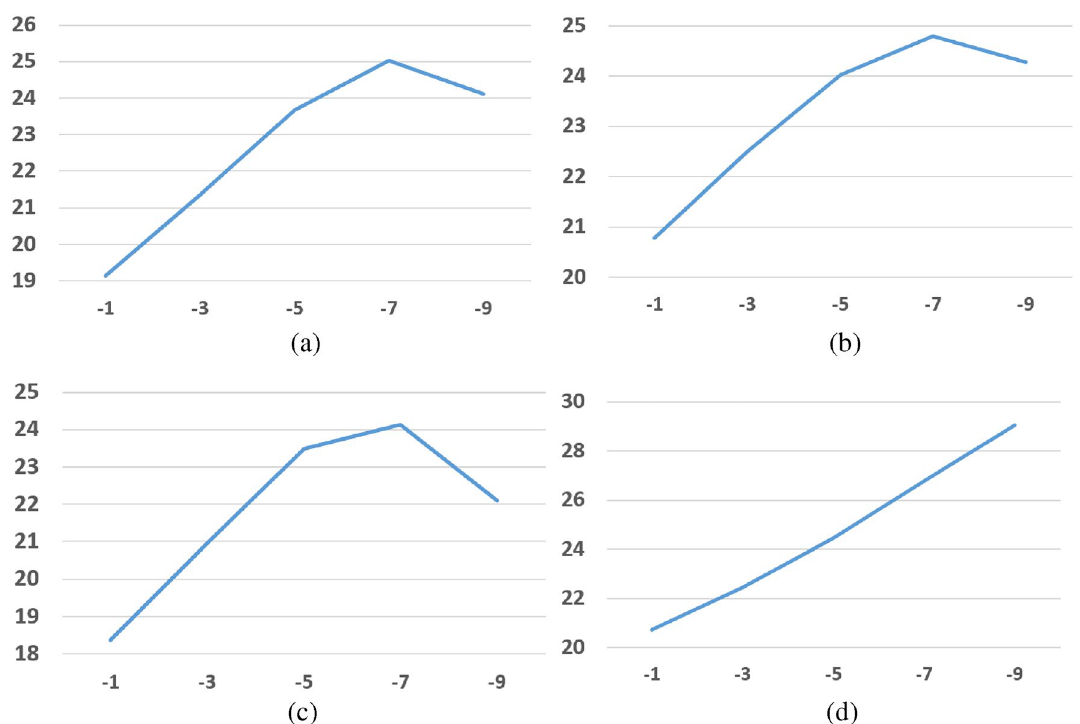
Figure 9. Denoising results curves of improved guided filtering with different smoothing parameters. ( a ) Couple ( σ 2 = 10 ) ( b ) Boat ( σ 2 = 15 ) ( c ) House ( σ 2 = 20 ) ( d ) Grass ( σ 2 = 10